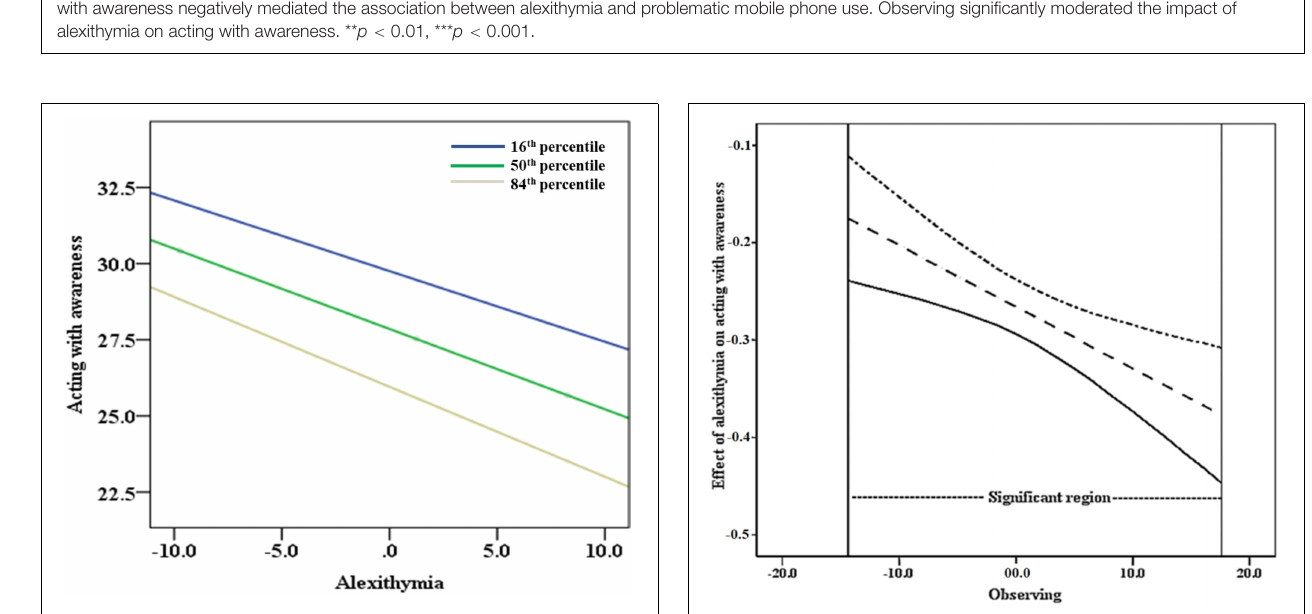
FIGURE 4 | Effects of observing with 95% confidence interval ( N = 901). The Johnson-Neyman (J-N) method was applied to measure the significant region in which observing significantly moderated the impact of alexithymia on acting with awareness. The upper and lower lines indicated the limits of confidence interval and the middle line indicated the effect of observing. The scores of statistical significance ranged from –14.371 to